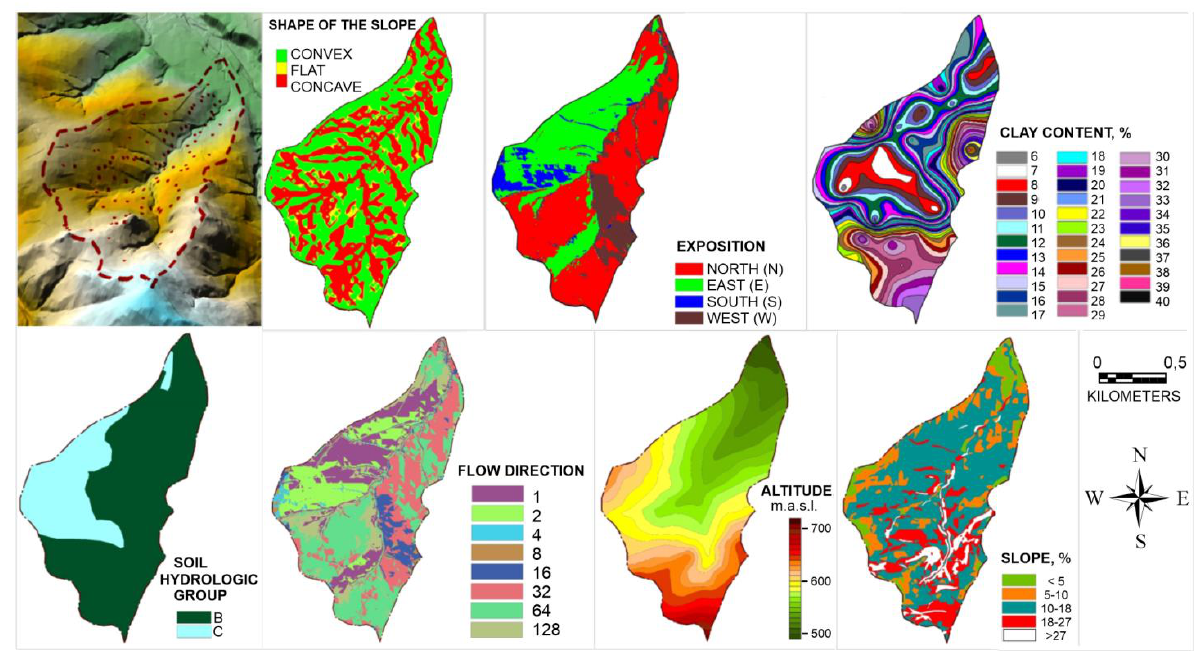
Figure 4. Physiographical parameters of the Mątny stream basin.